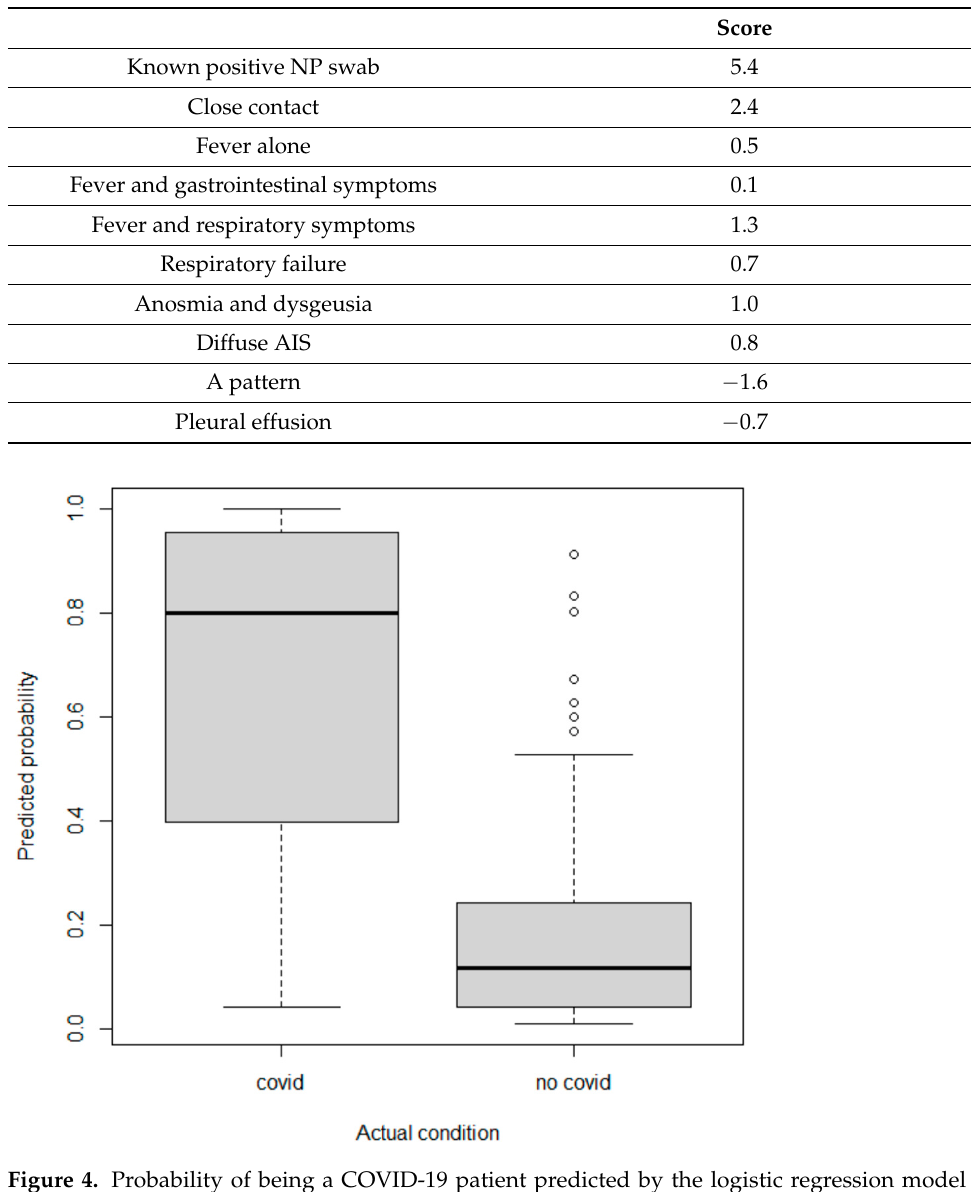
Figure 4. Probability of being a COVID-19 patient predicted by the logistic regression model is plotted against the actual patient status. Table 5. Scores based on the logistic regression classifier. NP, nasopharyngeal. AIS, alveolar-inter- stitial syndrome.